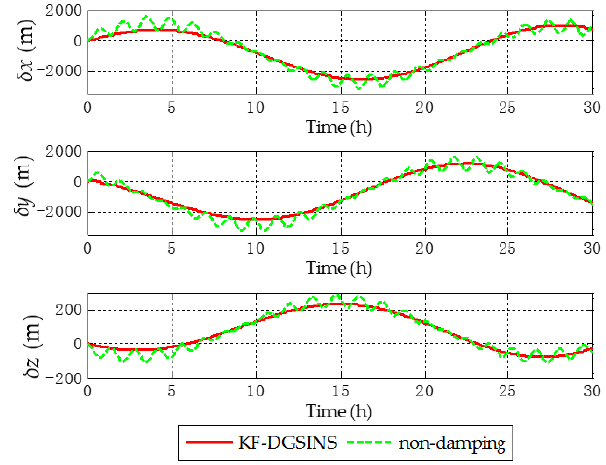
Figure 6. Grid level velocity errors of the simulation results.